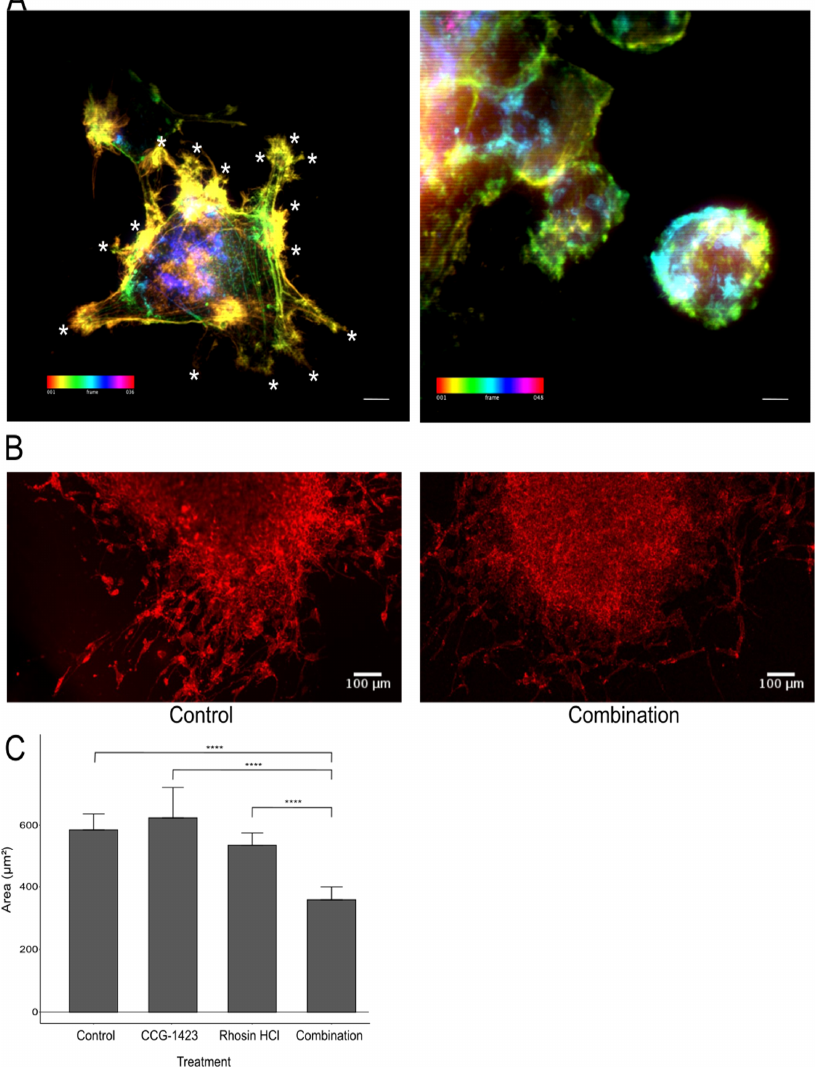
Figure 4. High resolution iSIM imaging and analysis of fixed spheroids and migrating cells within collagen plugs. ( A ) Top image: a single cell in untreated spheroids emanating from the orig- inal spheroid core. Asterisks show filopodia. Right hand image: the elongated shape disappears after treatment with inhibitor and is replaced by a rounded phenotype. Fluorescent label = Alexa